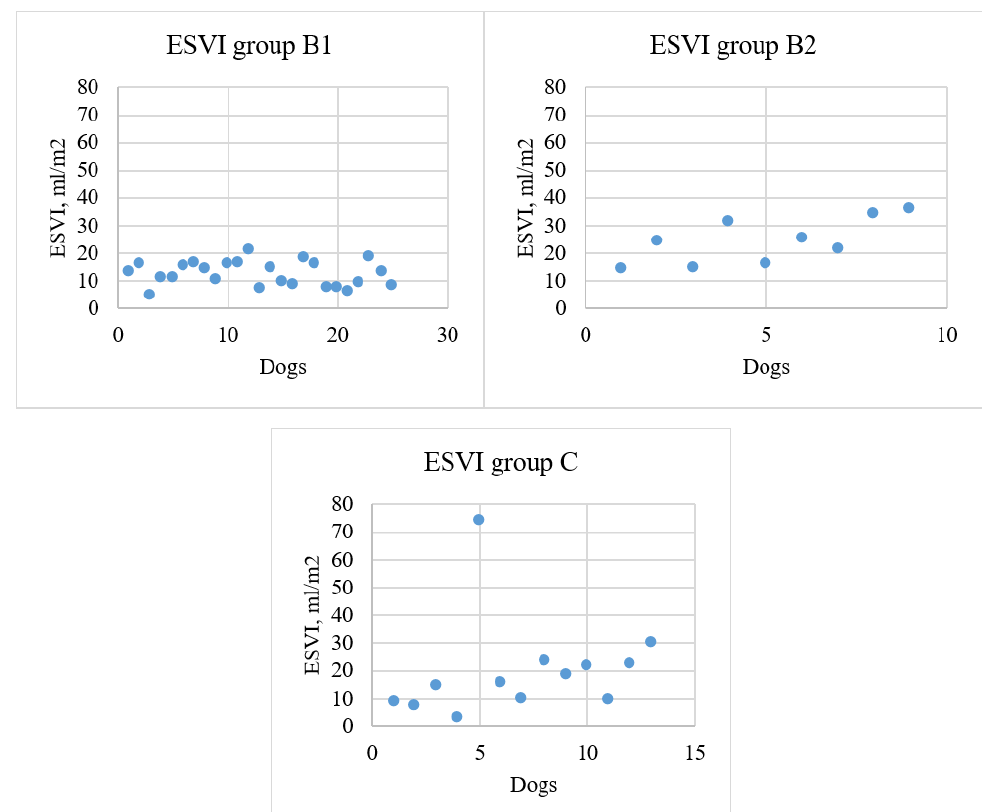
Fig. 2 . Spot diagram of the ESVI values indexed to the body area of experimental animals with the progression of